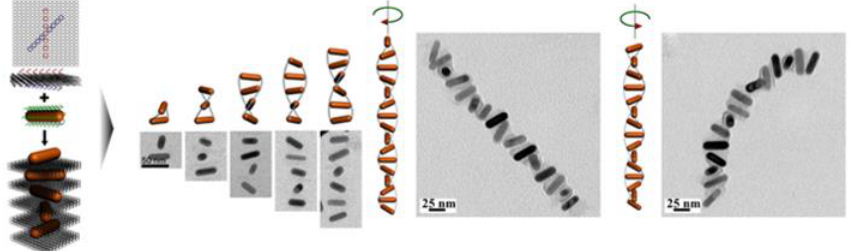
Figure 2. Au nanorod (AuNR) helical superstructures (helices) with tailored chirality (reproduced with copyright permission from [46], American Chemical Society).